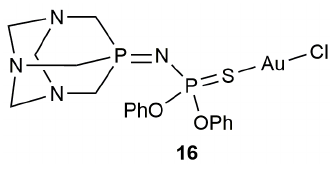
Figure 5. Structure of the iminophosphorane-gold(I) complex 16 .